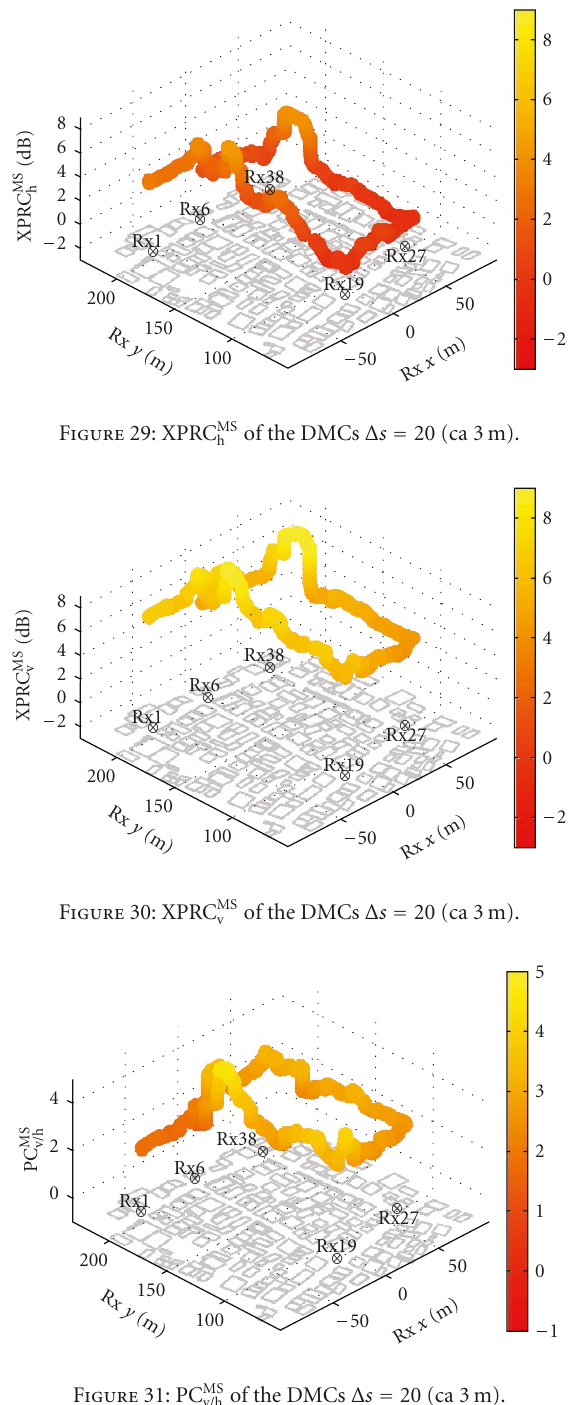
Figure 34: PC BS of the DMCs Δ s = 20 (ca v/h